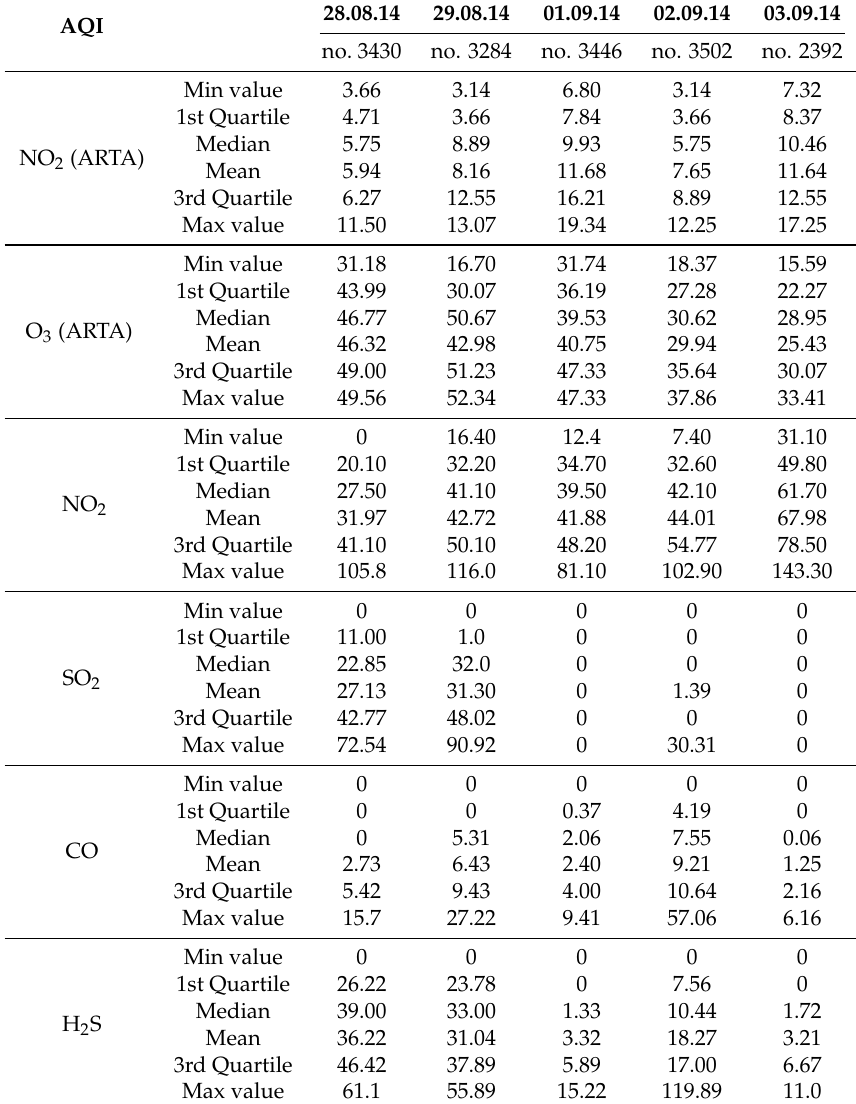
Table 6. AQI data analyses over the Smart